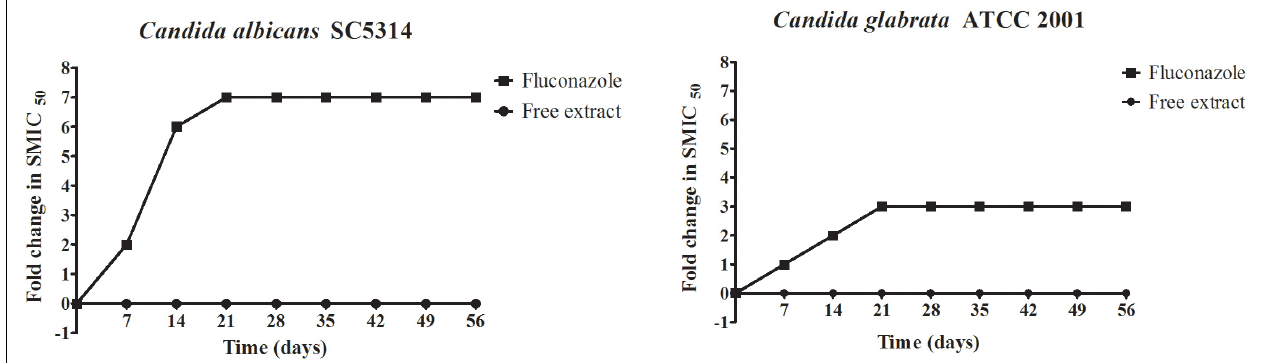
FIGURE 1 | Serial passage of C. albicans SC5314 and C. glabrata ATCC 2001 in the presence of the free extract or fluconazole to assess the potential for the development of resistance.